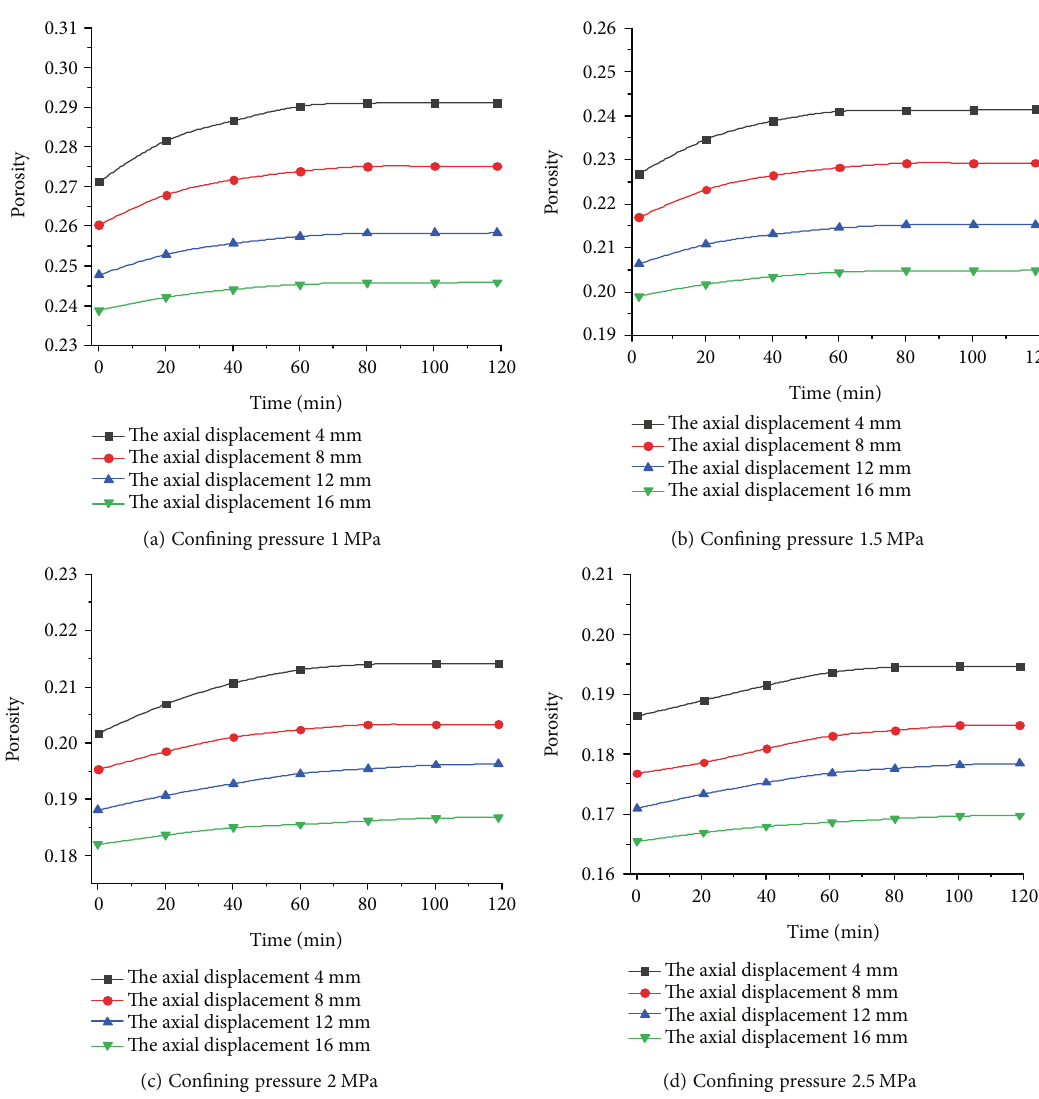
Figure 6: Porosity — time curve under di ff erent con fi ning